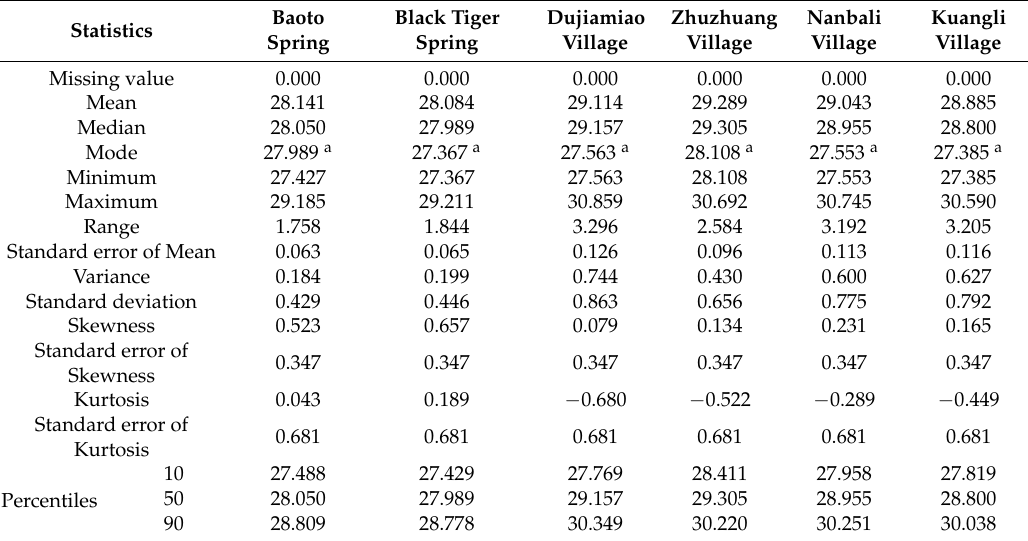
Figure 4. Condition of karst groundwater table, rainfall and recharge quantity from 2014 to 2017. Table 1. Basic information and statistical characteristics of karst groundwater table data.